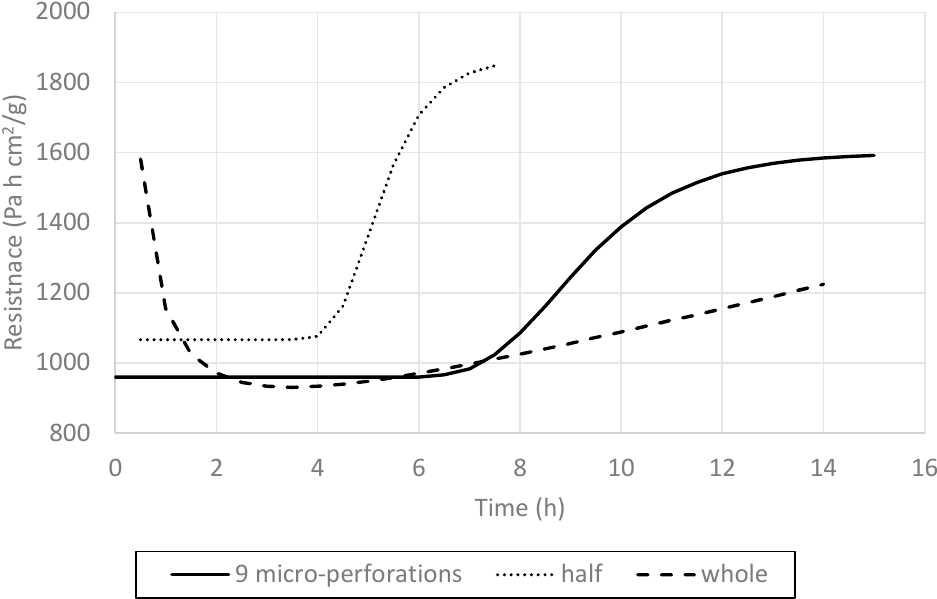
Figure 15. Comparison of mass-transfer resistance profiles as affected by the main treatments.